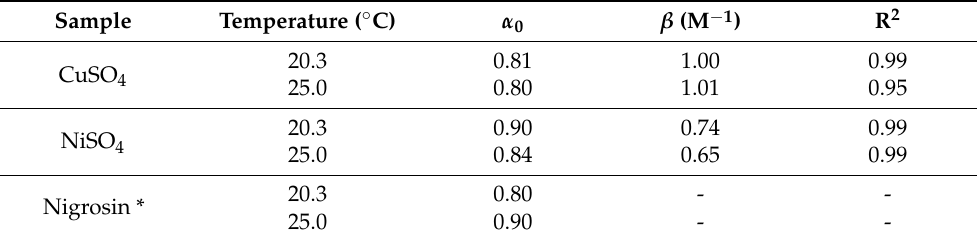
Table 3. Coefficients of Equation (13) obtained by linear regression of the curves α sample as a function of the molar concentration of each compound. The coefficient of determination (R 2 ) was computed.